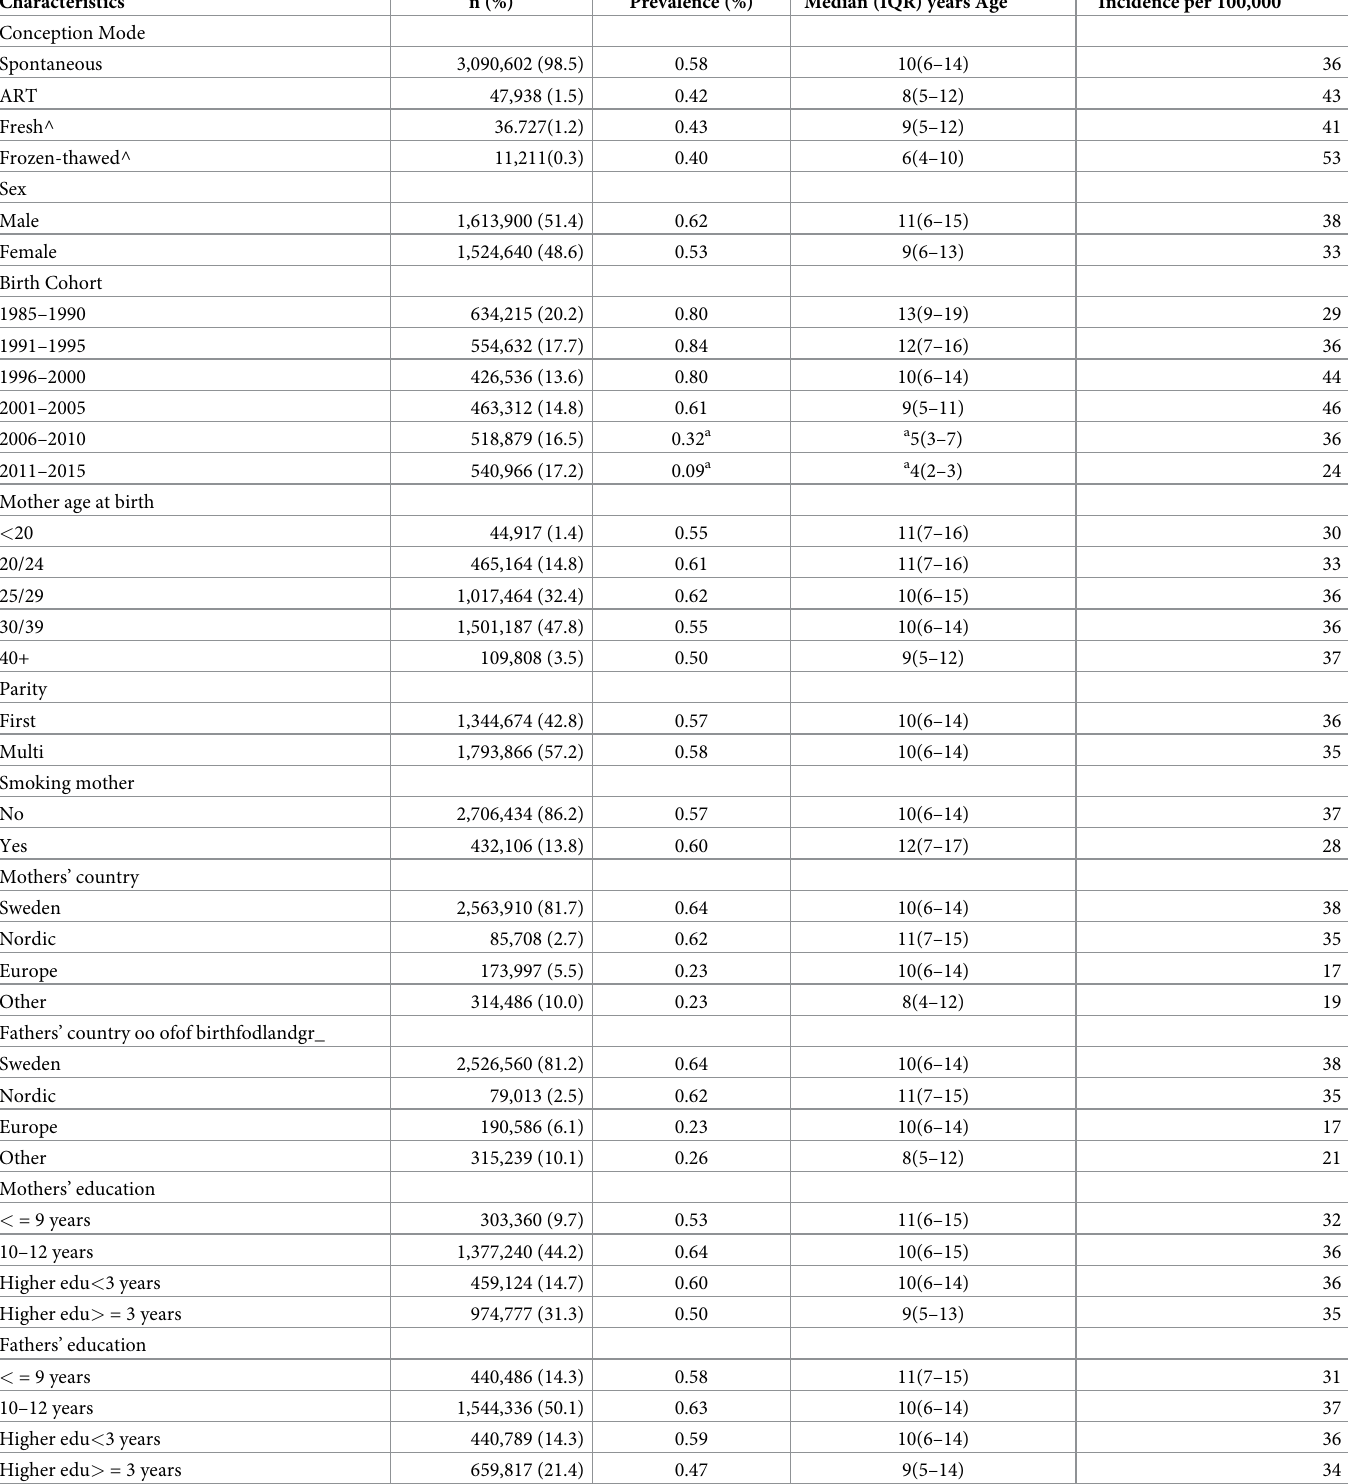
Table 1. Distribution of children’ characteristics and incidence rate of type-1 diabetes.